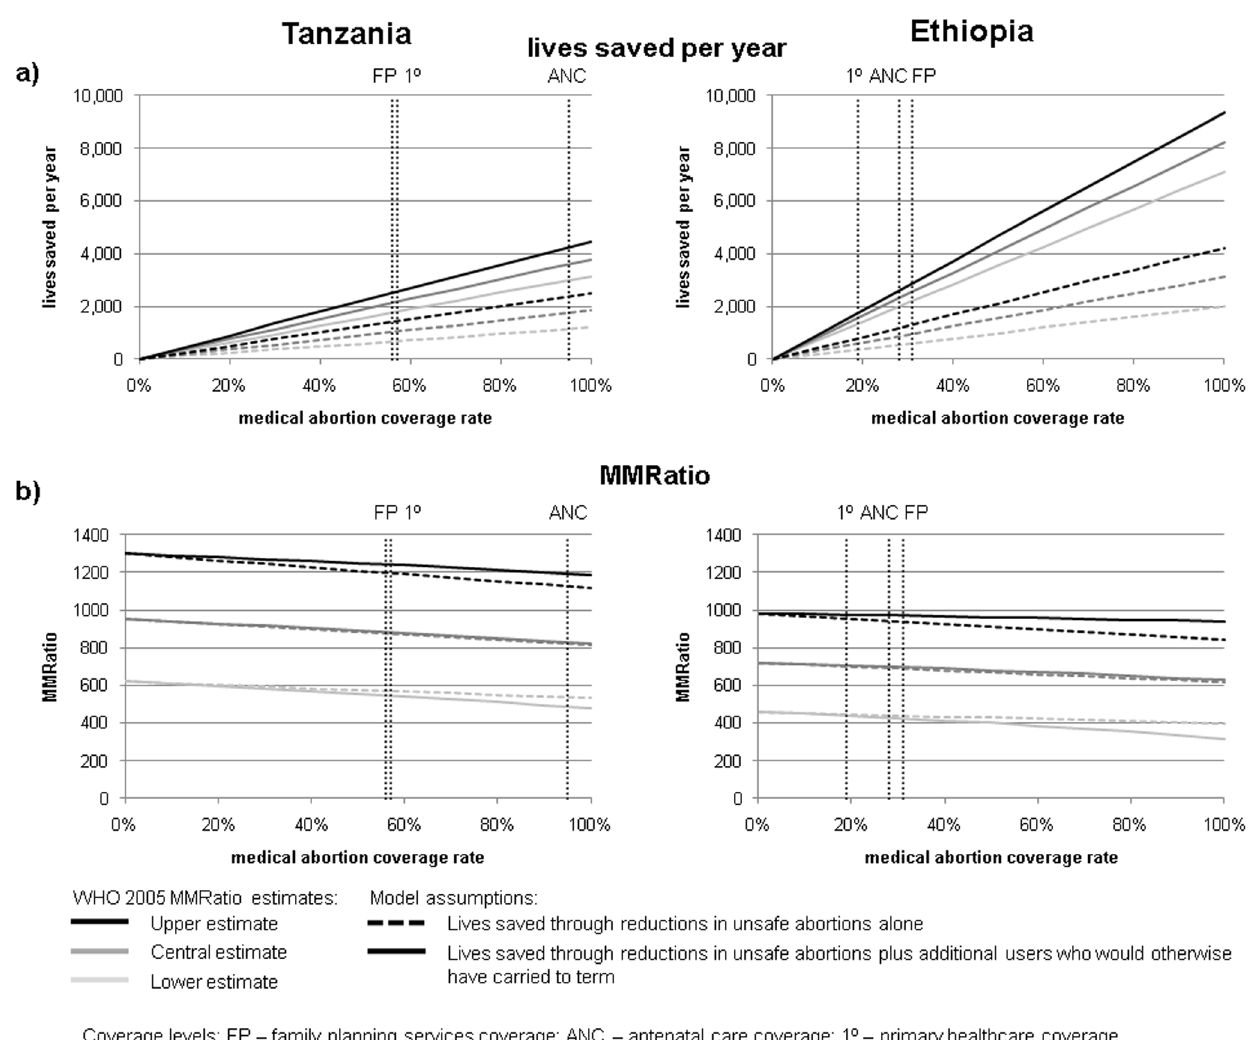
Figure 3. Relationship between hypothetical coverage level of medical abortion services and a) number of women’s lives saved per year and b) the MMRatio for Tanzania and Ethiopia. All scenarios assumed medical abortion uses misoprostol-only (effectiveness 85% first trimester, 80% second trimester); that coverage of medical abortion services is the same for women who would have had an unsafe abortion and those who would have gone to term; proportion of maternal mortality that is abortion-related is 17% (regional estimate) and proportion of pregnancies which are unwanted/mistimed is 21.8% for Tanzania and 33.8% for Ethiopia. We assume a conservative estimate of lives saved by showing the worst case scenario: Figure 2a Scenario 3, Figure 2b Scenario i. That is, of those women whose medical abortion fails who would otherwise have died from unsafe abortion, 100% are assumed to die (from seeking a second, but unsafe, abortion). Women whose medical abortion fails who would otherwise have gone to term are assumed not to seek a second abortion of either type, and carry the same mortality risk associated with a pregnancy going to term.